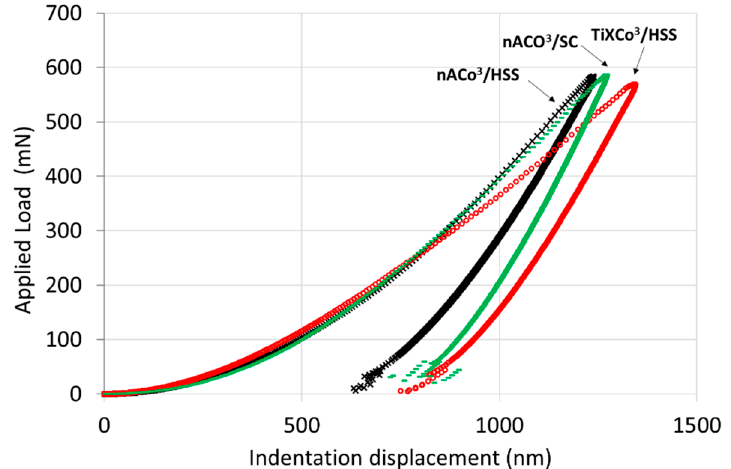
Figure 5. Load-displacement curves of all samples.